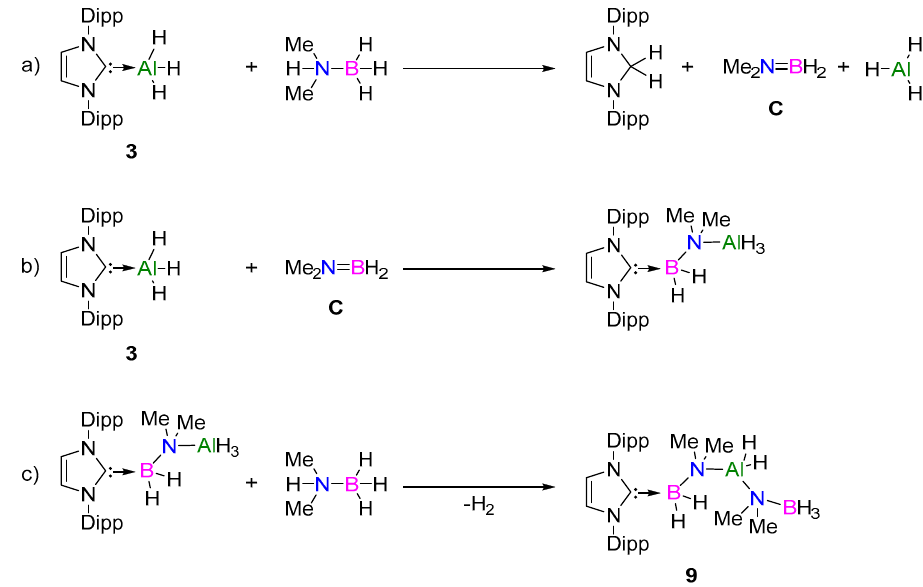
Figure 7. Proposed sequence of reactions which result in the formation of compound 9 . ( a ) Initial deprotonation of Me 2 NHBH 3 by NHC rather than Al–H. ( b ) Insertion of C into NHC–Al bond. ( c ) Deprotonation of Me 2 NHBH 3 by Al–H bond for formation of compound 9 .